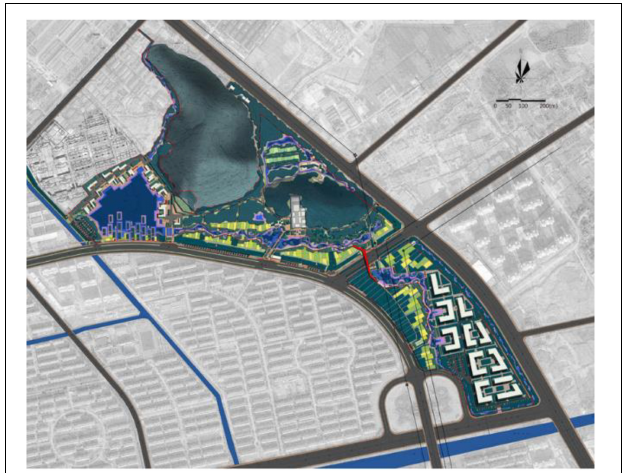
FIGURE 4 | Early master plan of Zhenshan Park made by Turenscape